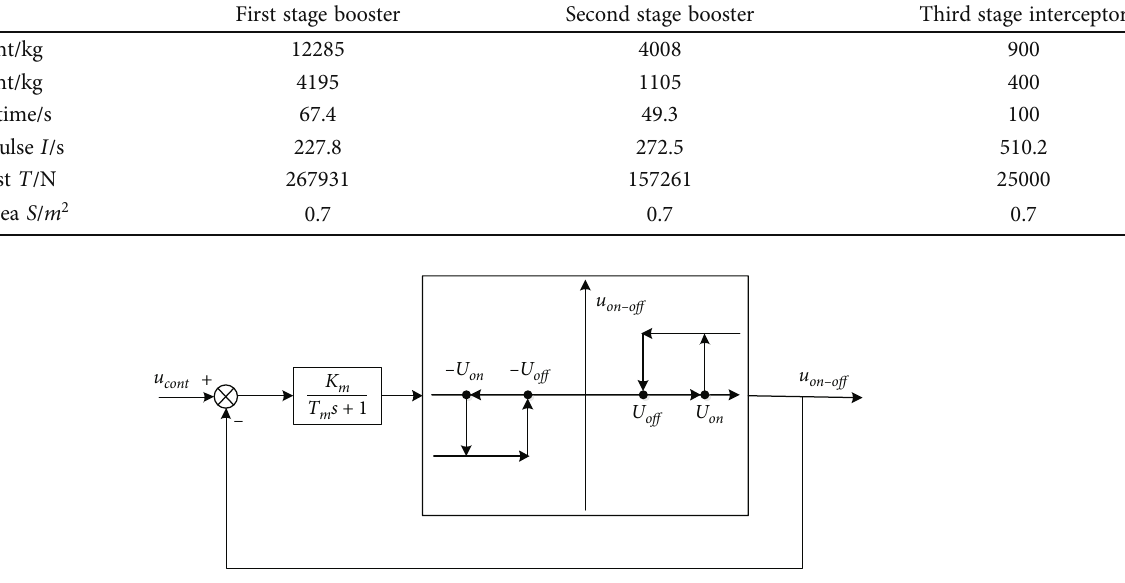
Figure 2: The principle diagram of the